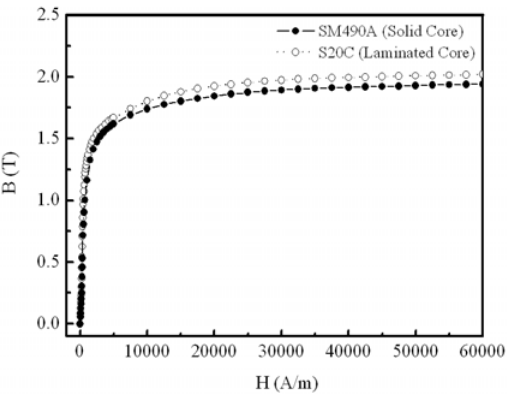
Figure 9. Magnetization curve of the core material